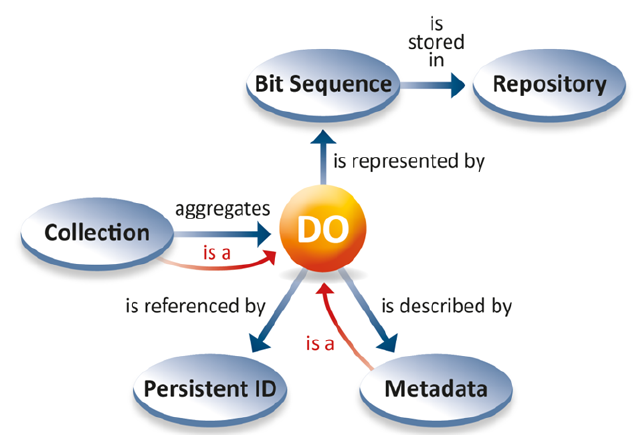
Figure 4. Relations between information associated with a Digital Object [13].